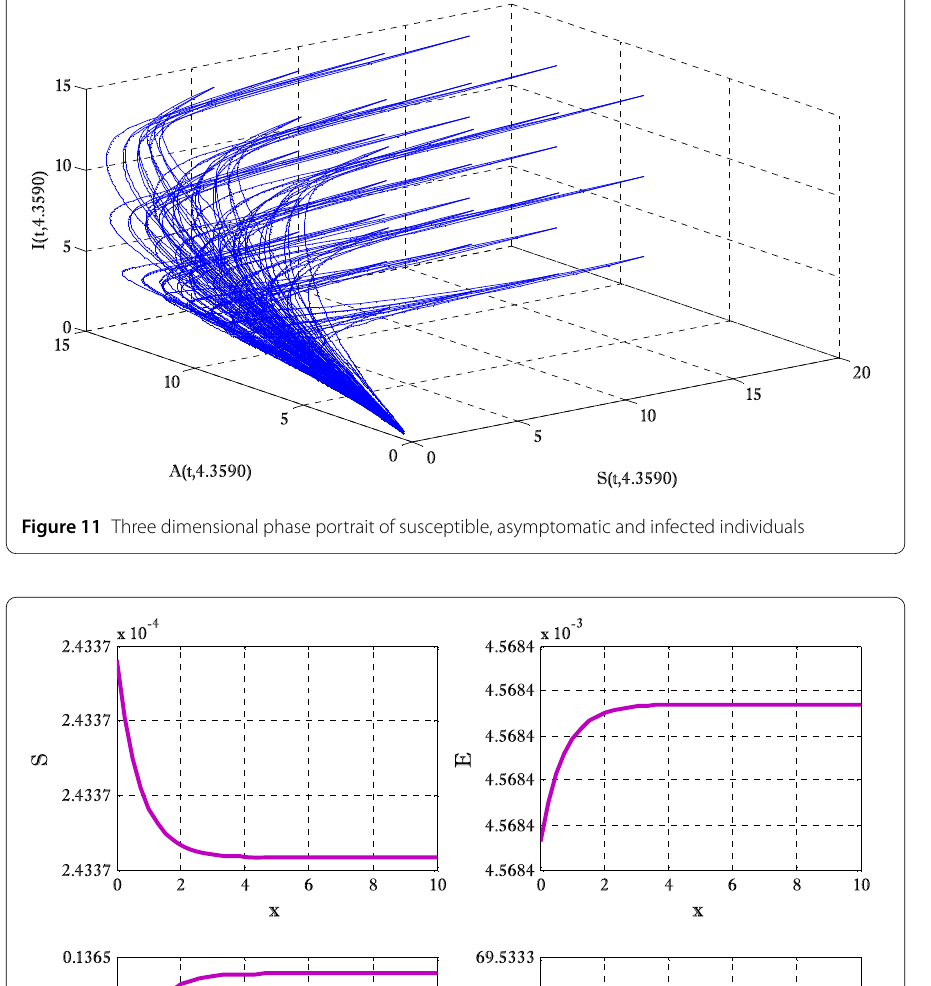
plotted individuals behave on t - and x -axis. In the captions of these figures N x and N t denote the number of grid points and number of time levels, respectively. The parameter a and b are used for choosing a particular